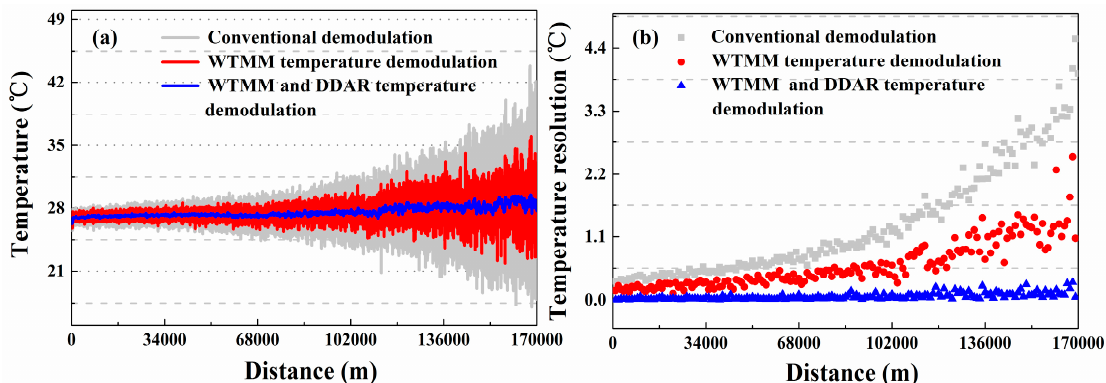
Figure 12. The ( a ) distributed temperature trends and ( b ) temperature resolutions for SDP scheme Figure 11. ( a ) The FRRDS trends along the sensing distance for SDP scheme. ( b ) The SNR using the conventional, WTMM and DDAR demodulation methods. measurement results using the different methods.